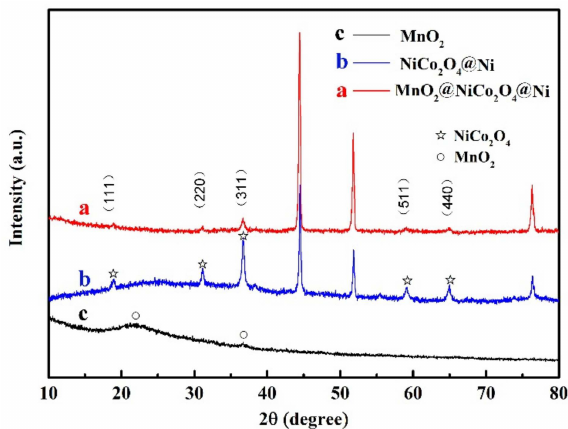
Figure 2. XRDpatternsforthematerials, ( a )MnO 2 @NiCo 2 O 4 @Ni, ( b )NiCo 2 O 4 @Niand( c )MnO 2 powder. SEM images of NiCo 2 O 4 nanowires and MnO 2 @NiCo 2 O 4 under di ff erent magnifications